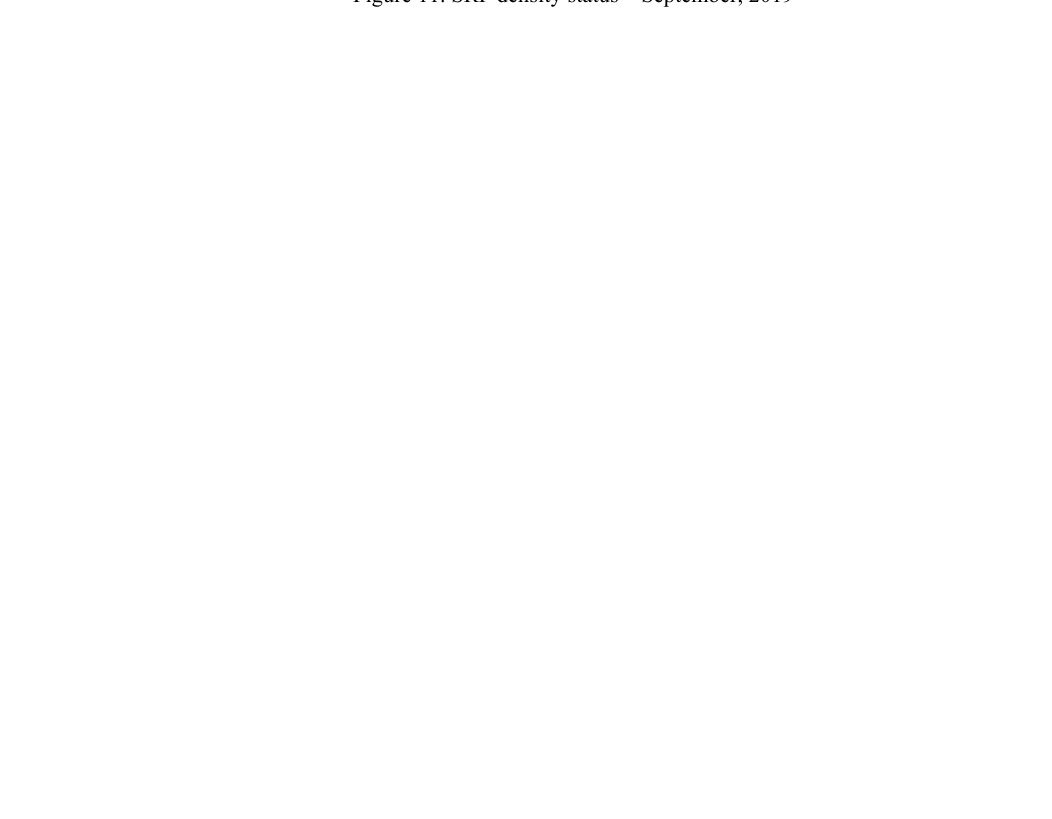
Figure 11. SRP density status – September,